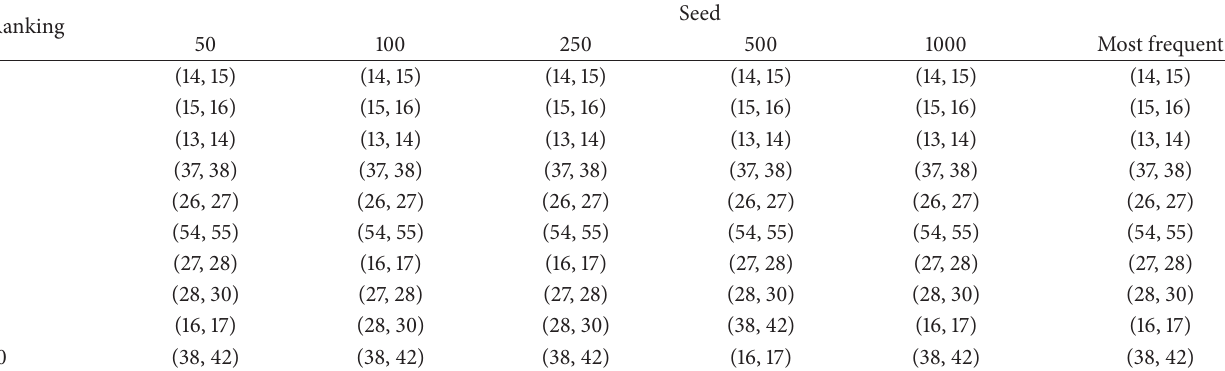
Table 4: List of ten top ranked edges for scenario